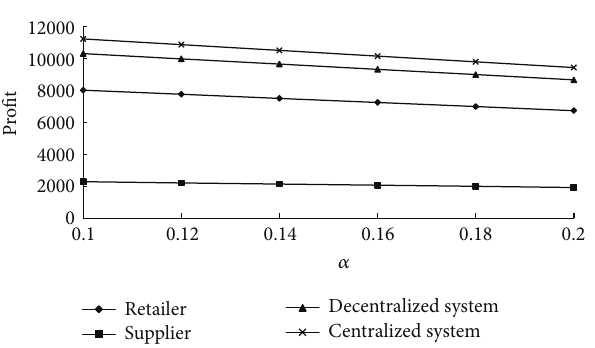
Figure 2: Profits of supply chain parties with deterioration factor 𝛼 .